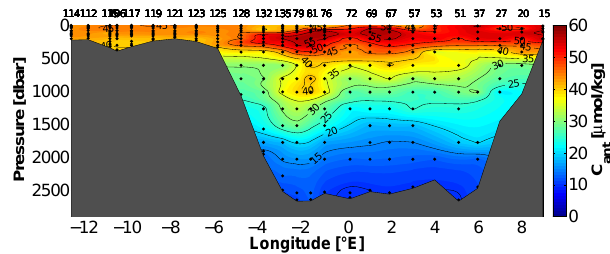
Figure 10. Distribution of anthropogenic carbon in µmolkg − 1 along the zonal section in the Fram Strait.